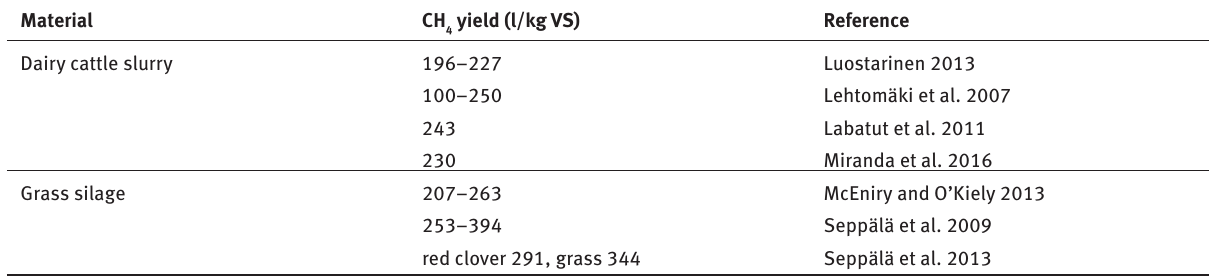
Table 5 : Dairy cattle slurry and grass silage methane potential in previous studies Material